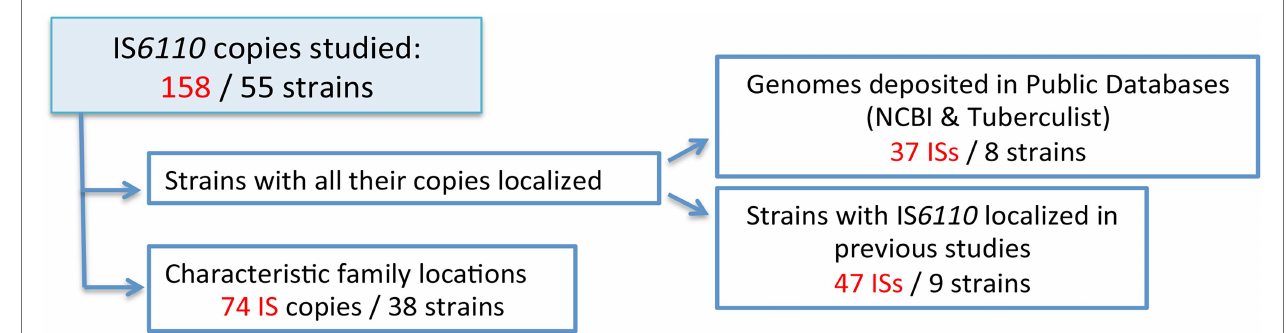
FIGURE 1 | Summary of the different IS 6110 copies studied in this